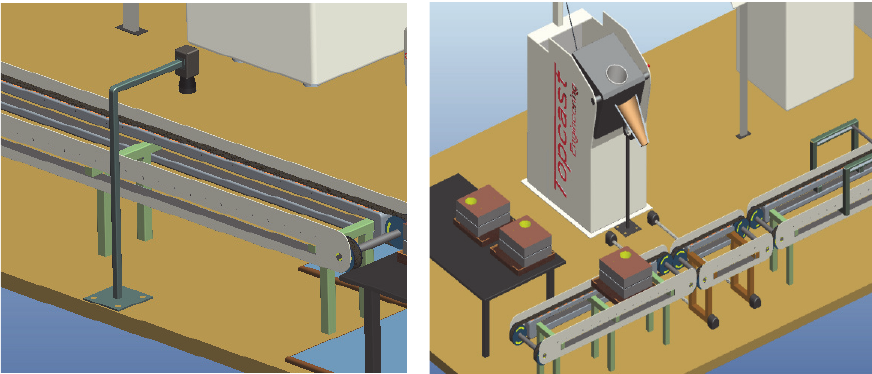
Figure 12: Simulated camera positioning on mold-pallet mechanical system.